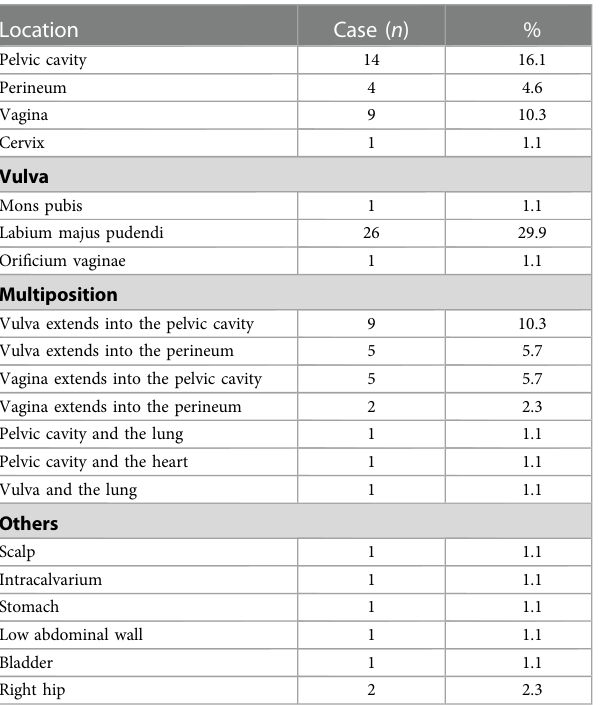
TABLE 1 Location of AAM.